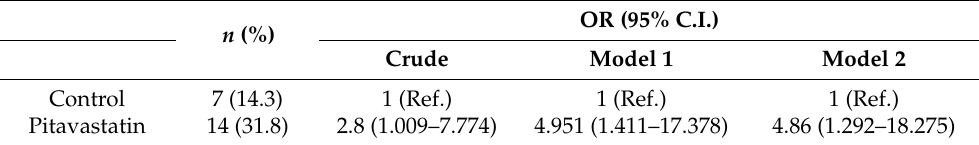
Table 3. Total adiponectin changes in PITA group with baseline above